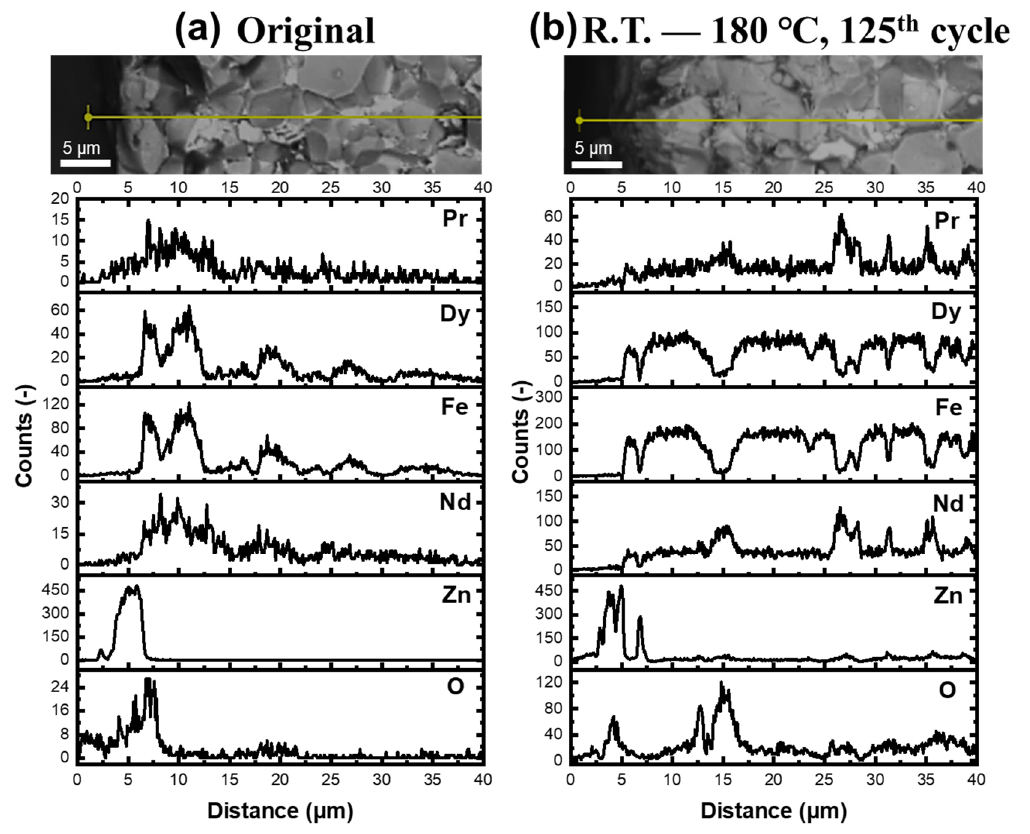
Figure 5. Cross-sectional backscattered SEM micrographs and EDS line scanning results of ( a ) the original sample and ( b ) the sample after 125th cycle from R.T. to 180 °C.